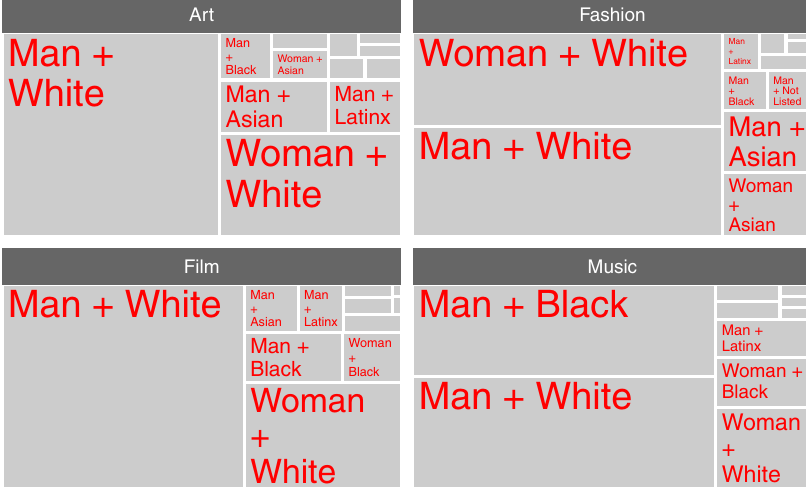
Fig. 3 Socially inferred intersecting gender-ethnicity within each creative domain, where each light gray rectangle represents proportion within the domain. Art is dominated by individuals inferred to be white men, fashion by white men and women, fi lm by white men, and music by black and white men. For readability, groups with small proportions are not labeled, but Table 1 provides the